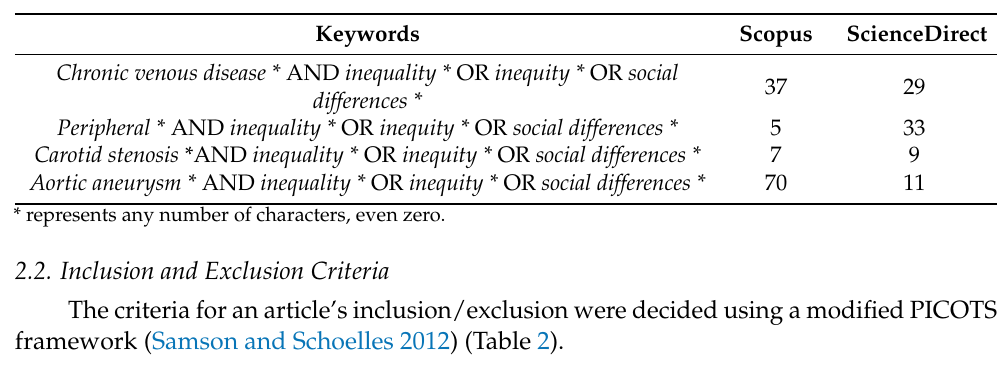
Table 1. Databases, search strategy, and number of articles extracted.